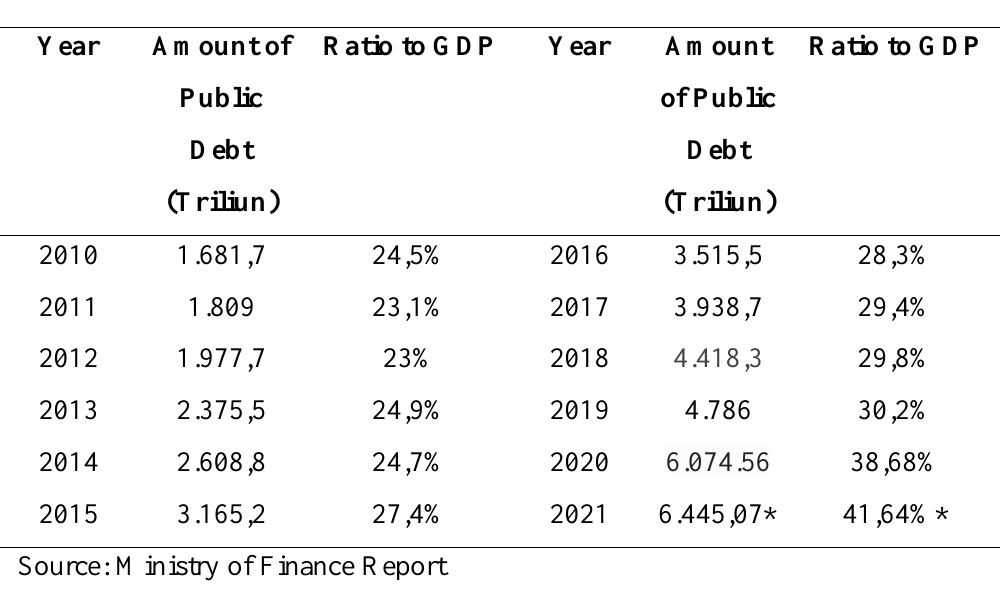
Table 4.1 Amount of Indonesian Public Debt and Its Comparison with the Value of GDP (Gross Domestic Product) in